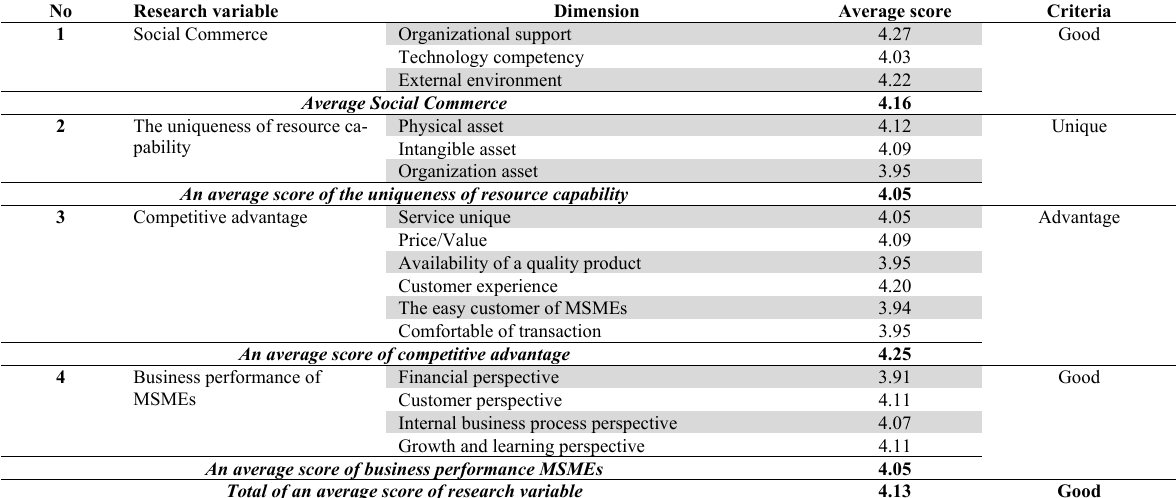
Recapitulation of research variables description No Research